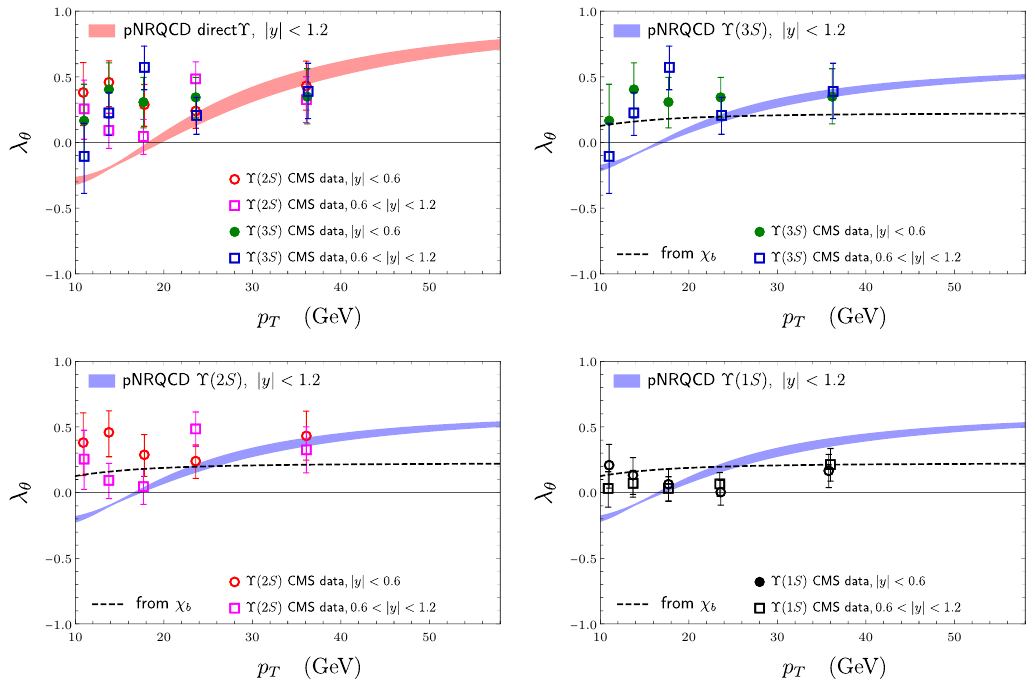
Figure 13 . pNRQCD results for the polarization parameter λ θ for directly produced Υ states (top left), inclusive Υ(3 S ) (top right), inclusive Υ(2 S ) (bottom left), and inclusive Υ(1 S ) (bottom right), compared to CMS data [81]. The polarizations of Υ from χ b decays are shown as black dashed